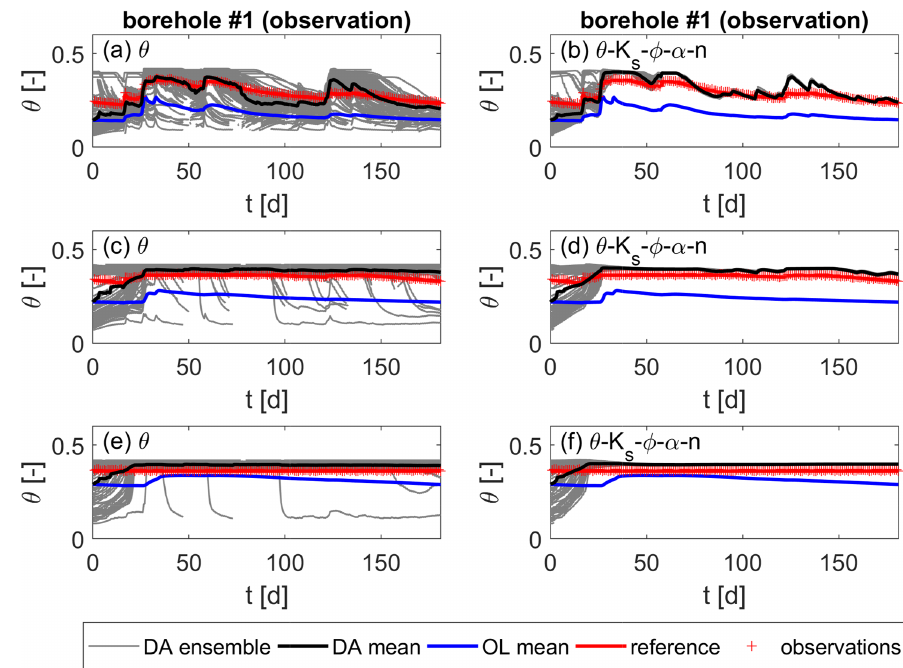
Figure 17. Soil moisture over time for the heterogeneous scenario with a simplified layered soil in the ensemble runs at one observation location. Values are taken at z 1 = 0 . 33m, z 2 = 0 . 75m, and z 3 = 0 . 95m below the surface from top to bottom. (a, c, e) Updates of soil moisture only. (b, d, f) Joint updates of soil moisture and all parameters.